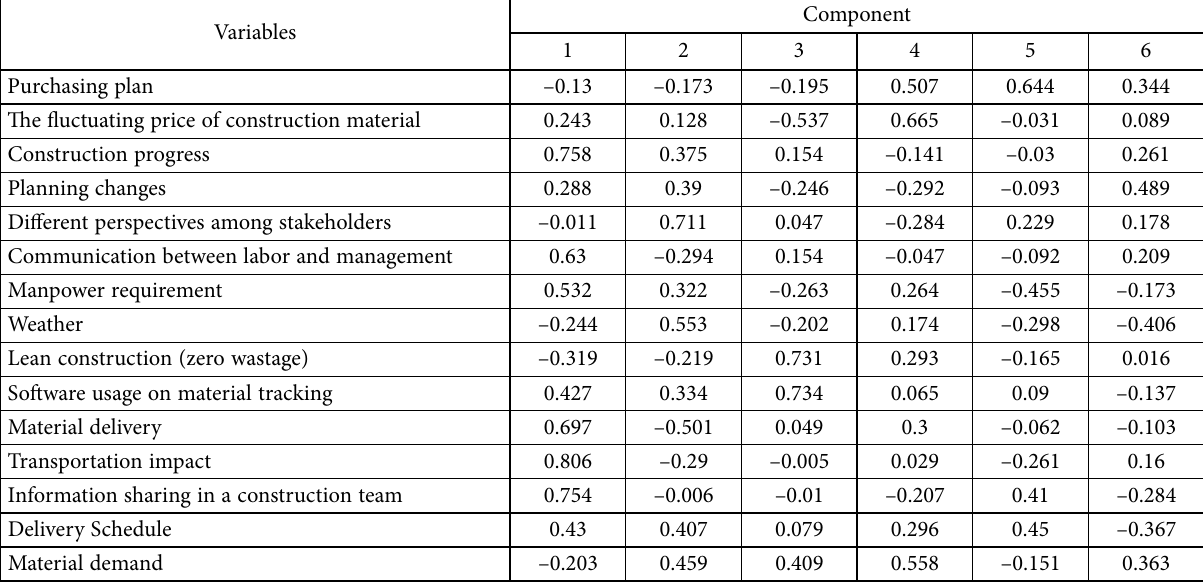
Table 4. The first rotated component